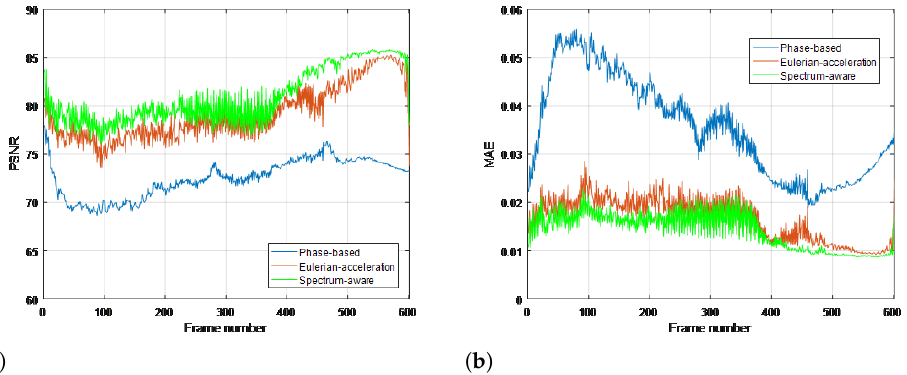
Figure 8. Objective metrics with ground truth for each magnification processing using ( a ) PSNR and